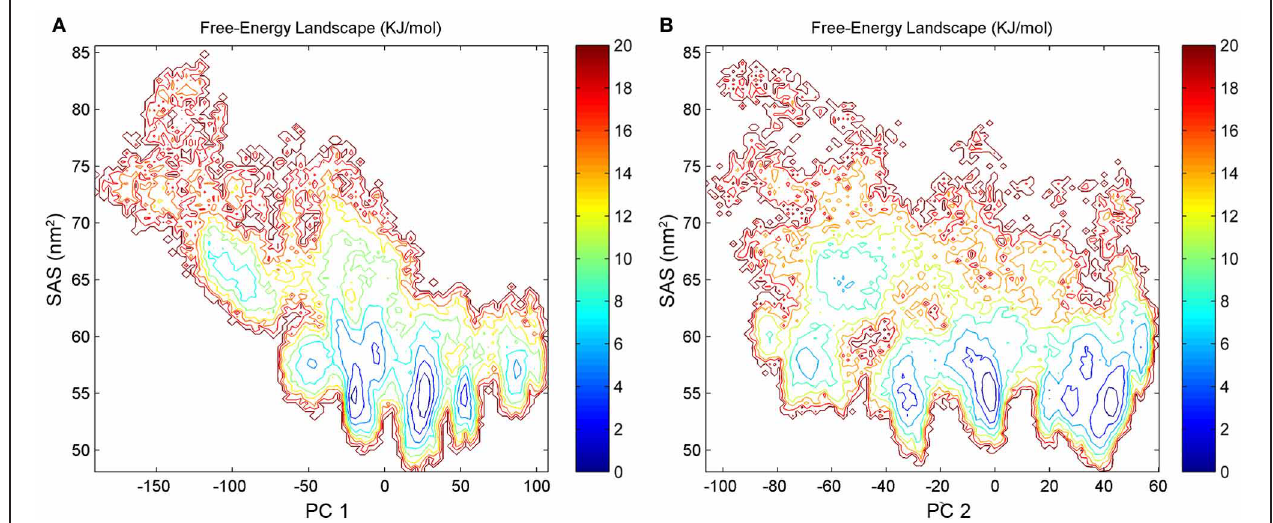
FIGURE 8 | FEL representations calculated using the first (A) or the second (B) PCs and SAS values as reaction coordinates. The free energy is given in kJ/mol and indicated by the color code shown on the figure.